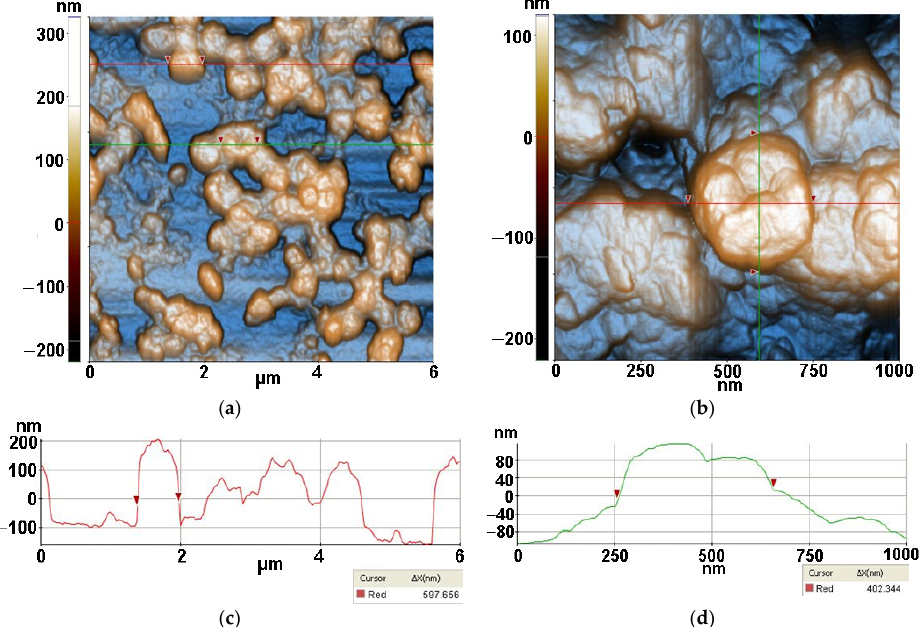
Figure 9. Two-dimensional AFM images of MC (from inoculum) with Lys/TiO 2 deposited on glass substrate, recorded at the scale of (6 μ m × 6 μ m) ( a ) and (1 μ m × 1 μ m) ( b ), with one characteristic surface profile for each scale: 6 μ m red ( c ) and 1 μ m green ( d ).